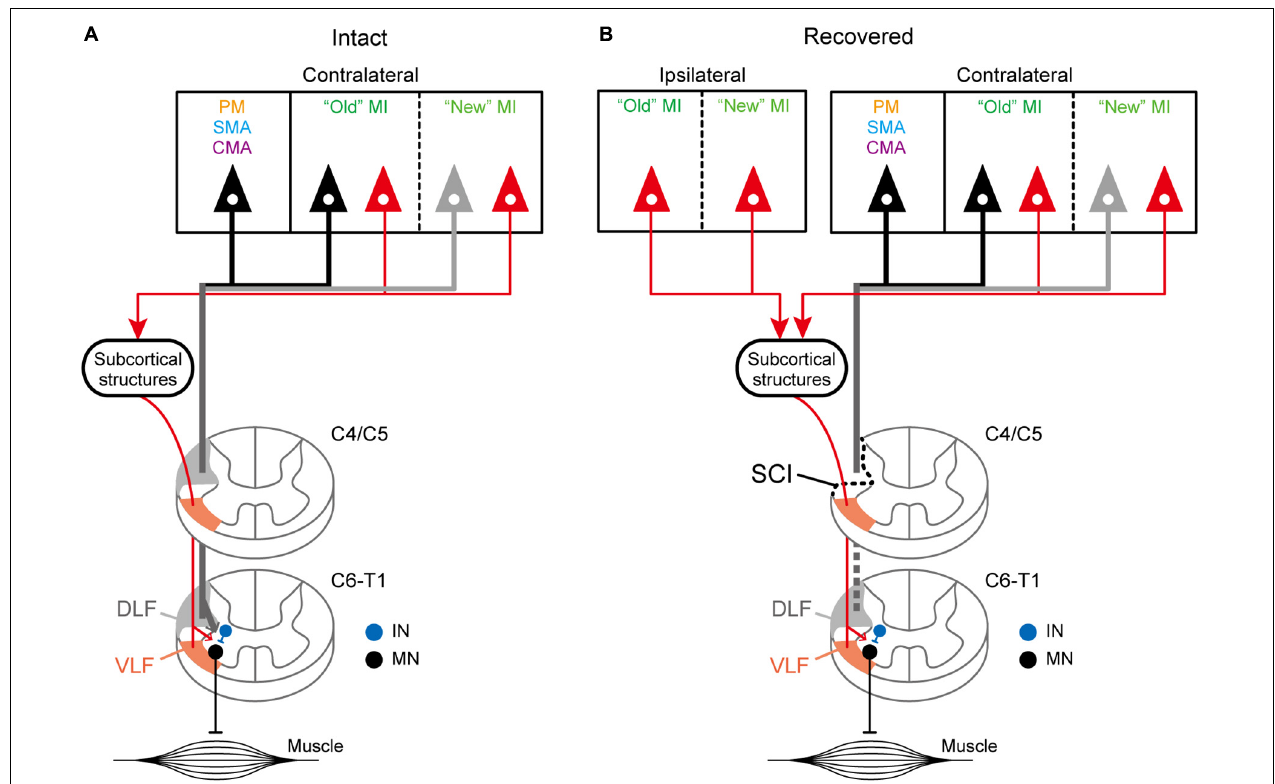
FIGURE 5 | Hypothetical schematics showing the distributed origins of diCSP. (A) Schematic diagram of the disynaptic inputs toward the spinal forelimb segments (C6–T1) through VLF (orange regions in the spinal cord). The monoCSP through DLF (gray regions in the spinal cord) originates predominantly from “old” M1 (black) and, to a lesser extent, from “new” M1 (gray) in the contralateral hemisphere (Experiment A). Other motor-related areas, such as PM, SMA, and CMA, also give rise to this pathway (black). On the other hand, the diCSP is derived nearly equivalently from both “old” and “new” M1 (red; Experiment C). Unlike monoCSP, the other motor-related areas do not contribute to this pathway. See the Discussion section for potential subcortical structures relaying the input via diCSP. (B) Schematic diagram of the reorganized diCSP after the monoCSP lesion. Hemisection of DLF above the forelimb segments (section C4/C5) results in recruitment of diCSP arising from the ipsilateral as well as the contralateral “new” M1 (Experiment D). IN, segmental interneurons; MN,